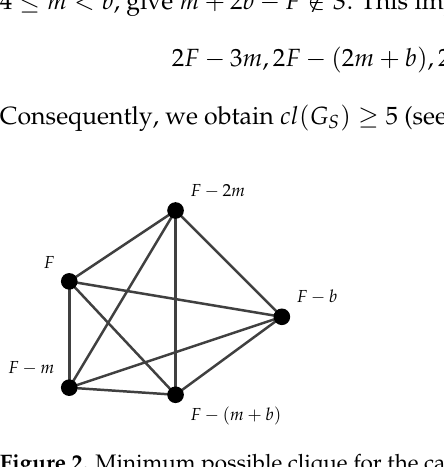
Figure 2. Minimum possible clique for the case m ≥